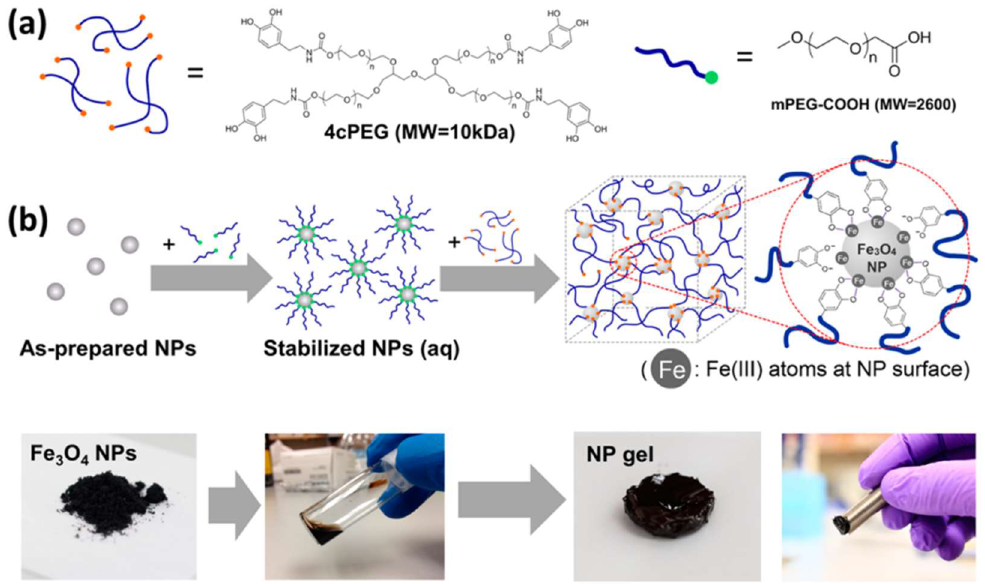
Figure 4. ( a ) The 4cPEG and mPEG-COOH structures of the polymers. ( b ) On the top is shown the preparation procedure for the Fe 3 O 4 particles-cross-linked hydrogel. At the bottom are shown representative pictures at each state. From left to right: Fe 3 O 4 dry powder, stabilized Fe 3 O 4 NPs in aqueous dispersion before gel assembly, the self-standing solid hydrogel obtained after assembly with 4cPEG, and magnetic attraction of the resulting gel. Adapted with permission from [36] . Copyright 2016, American Chemical Society.